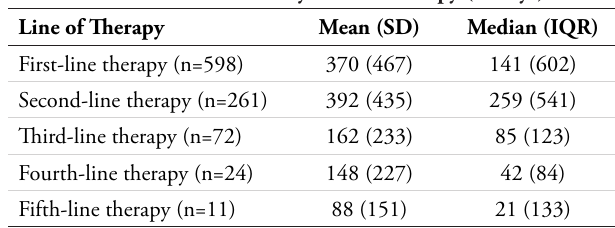
Table 2. Treatment Duration by Line of Therapy (in days) Line of